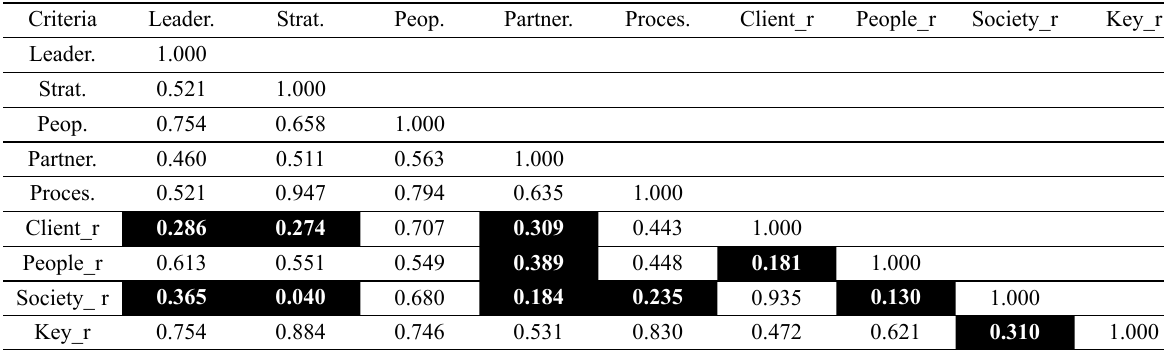
Table 11. Example of the correlation matrix for the Investors’ perspective Criteria